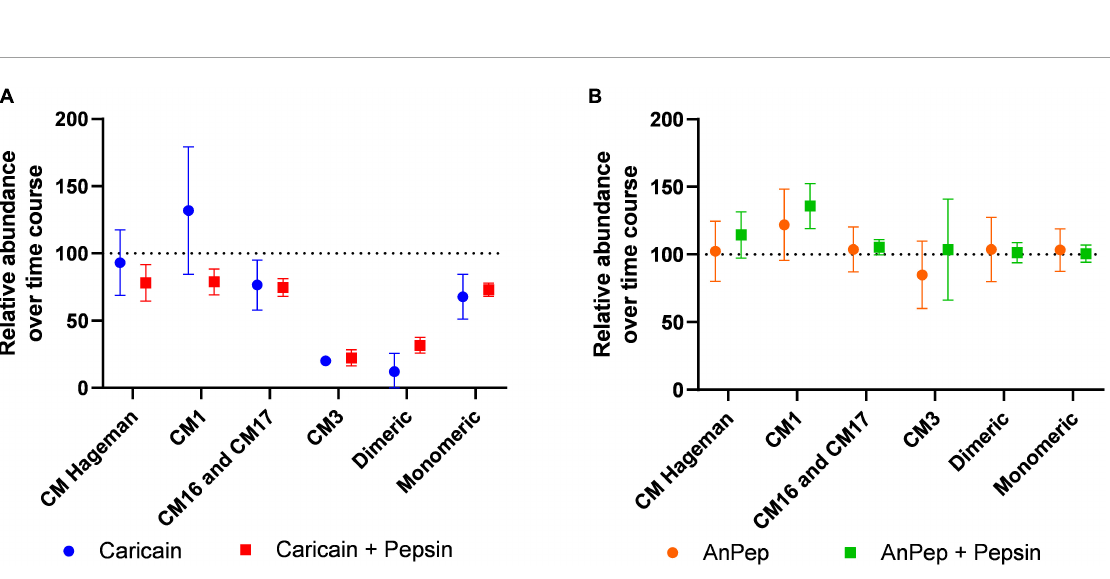
FIGURE6 Peptide abundance after 60 min digestion expressed as a percentage of abundance in the 0 min time point. ATI CM16 and CM17 peptides showed similar results and are grouped together (A) caricain significantly digests all ATI types except for CM Hageman and CM1, though in conjunction with pepsin, caricain digests these too. (B) An-Pep does not digest ATI peptides within 60 min even in conjunction with pepsin. Error bars indicate 95% confidence